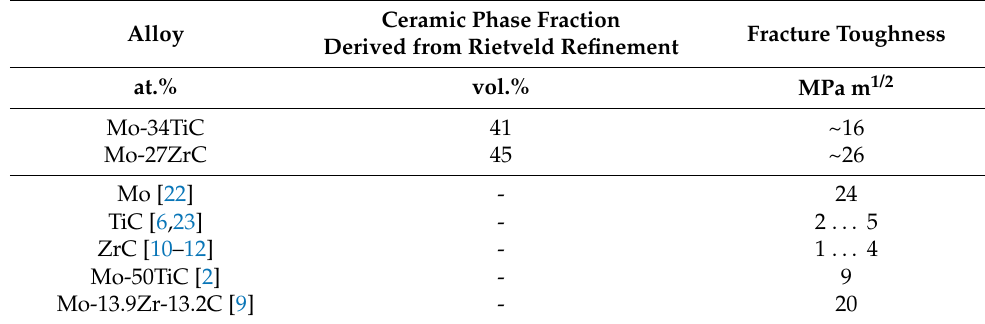
Figure 2. X ‐ ray diffraction data for alloy Mo ‐ 34TiC and Mo ‐ 27ZrC, representing the existence of two Figure 2. X-ray diffraction data for alloy Mo-34TiC and Mo-27ZrC, representing the existence of two phases in the composites: Mo ss , TiC/ZrC. phases in the composites: Mo ss , TiC/ZrC. Table 1. Microstructural features of the Mo-XC alloys compared with literature. Ceramic Phase Fraction Alloy Fracture Toughness Derived from Rietveld Refinement at.% vol.% MPa m 1/2 Mo-34TiC 41 ~16 Mo-27ZrC